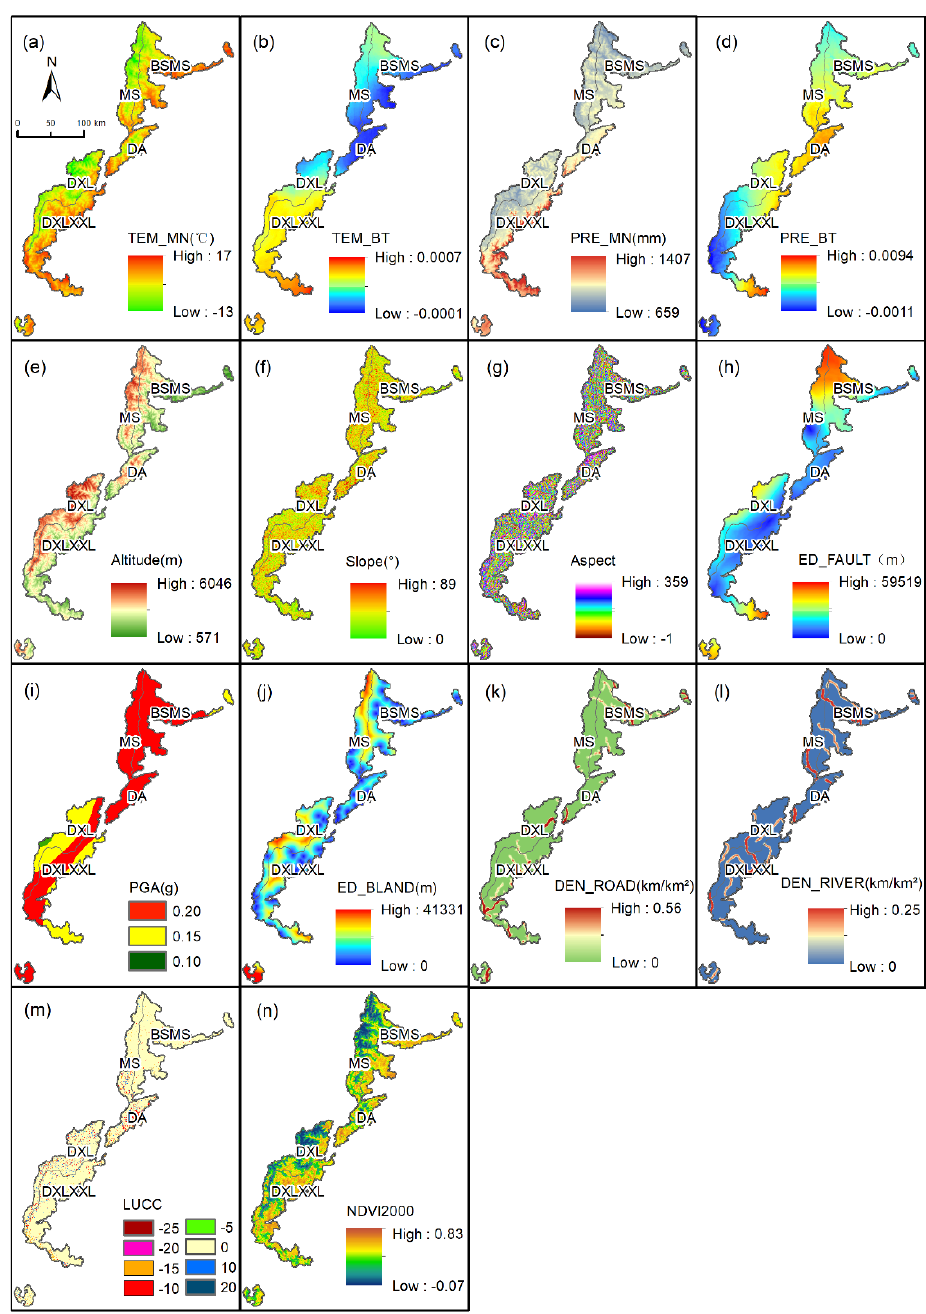
Figure 2. Driving factors used for GWR Model. ( a ) Temperature mean value; ( b ) temperature slope; ( c ) precipitation mean value; ( d ) precipitation slope; ( e ) elevation; ( f ) slope; ( g ) aspect; ( h ) Euclidean distance from fault; ( i ) seismic peak acceleration; ( j ) Euclidean distance from built-up land; ( k ) road density; ( l ) river density; ( m ) land-use change index; ( n ) NDVI in 2000.